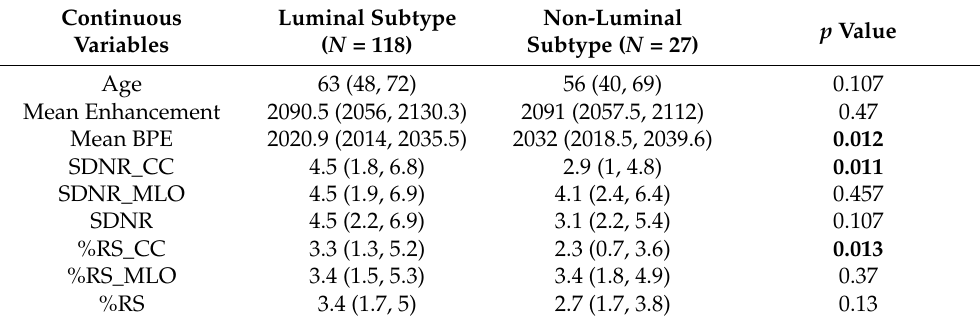
Table 4. Distribution of continuous radiological findings according to molecular subtypes. Continuous Luminal Subtype Non-Luminal Variables ( N = 118) Mean